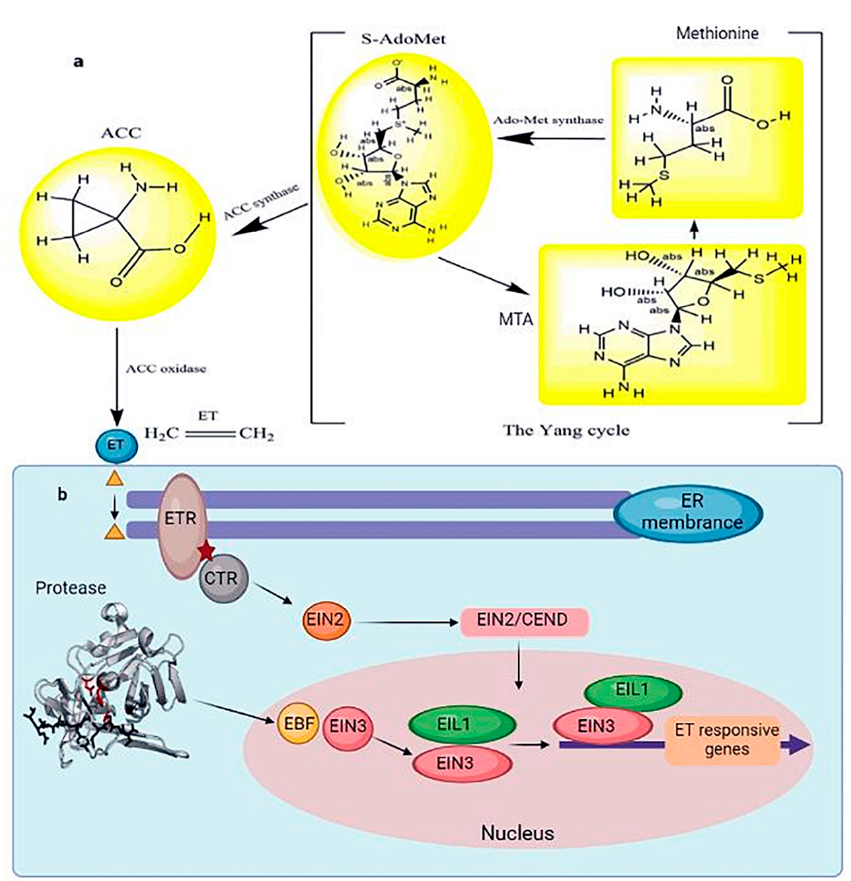
Figure 5. ( a ) The schematic Yang cycle to exhibit the biosynthesis of ET in higher plants. In many cells, methionine produces S-adenosylmethionine under the catalysis of the methyl donor methionine adenosyltransferase. Under the catalysis of 1-aminocyclopropane-1-carboxylic acid synthase, the ET precursor 1-aminocyclopropane-1-carboxylic acid is generated. 1-aminocyclopropane-1-car- boxylic acid oxidase catalyzes the production of ET from ACC. ( b ) ET signal transduction in re- sponse to abiotic stress. At the same time, 5 methylthioadenosine, also known as MTA, is produced. Methylthioadenosine, in turn, can be utilized to produce new methionine. An enzyme cascade re- action is denoted by an arrow when an enzyme catalyzes it. When ET binds to ETR, it causes the CTR protein to be released. The main controllers of ethylene signaling that support a range of plant responses to ethylene are the transcription factors EIN3/EIL1. The signaling outcome of ethylene, which controls various characteristics of plant development and stress responses, must be modu- lated correctly according to the spatiotemporal and environmental circumstances. CTR activates EIN2 by degradation, and the carboxyl end of EIN2 translocates into the nucleus and activates EIN3 transcription. Subsequently, EIN3 induces ERF expression, inhibiting ET-responsive gene expres- sion. Bars represent inhibition, and arrows represent activation. EIN3 is a nuclear protein acting as a plant-specific transcription factor. It plays a crit- ical role in the ET signaling pathway by directly regulating the expression of ET-respon- sive genes. Arabidopsis has five EIN3 homologous genes (EIL1–5), and EIN3/EIL1 con- trols the expression of most ET-responsive genes, as reflected by the finding that EIN3/EIL1 defects result in ET insensitivity. Although ET treatment does not alter EIN3 mRNA levels, it causes the accumulation of the EIN3 protein [80]. In the absence of ET, EIN3 binds to the F-box protein EBF, which results in its recruitment to the Cullin protein complex for ubiquitination. Therefore, the level of EIN3 protein in plants is deficient un- der physiological growth conditions. However, in the presence of ET, a portion of EIN2 translocates into the nucleus, promoting EBF degradation and subsequent EIN3 stabiliza- tion [7,81]. Numerous studies have shown that the EIN3/EIL complex promotes salt stress